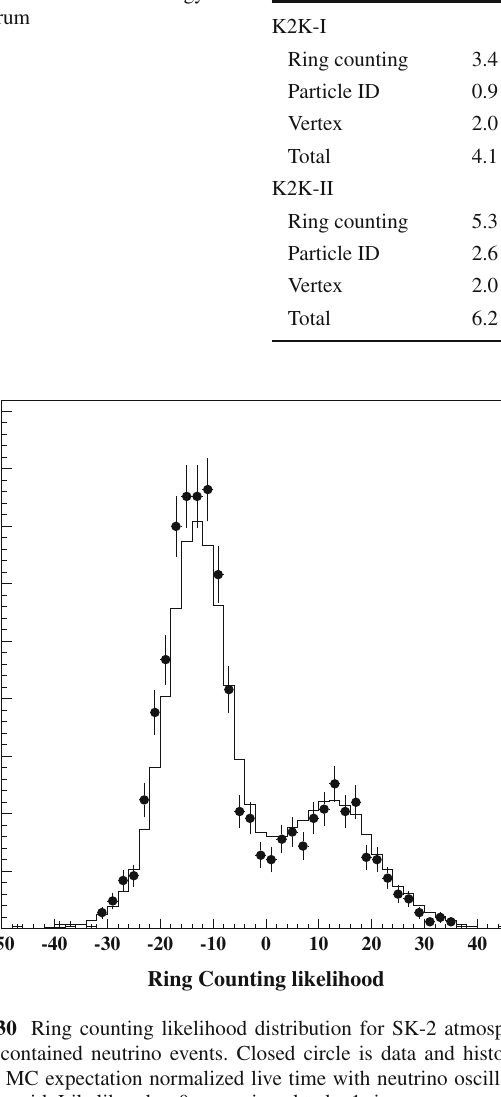
comes from the vertex reconstruction in a fiducial volume.